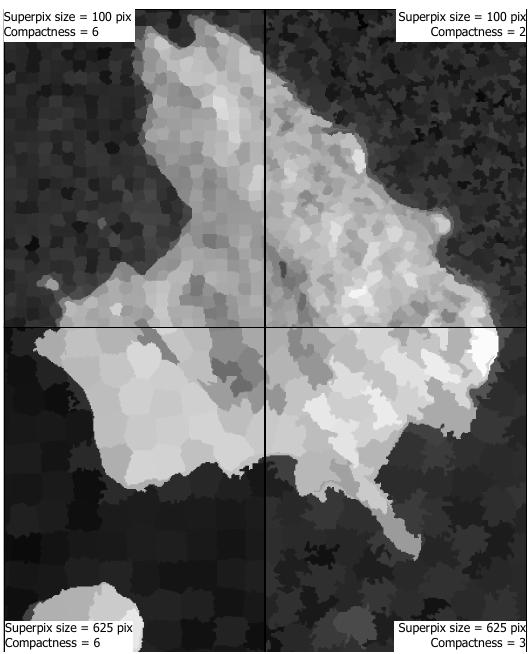
Figure 2. Median filtering based on the superpixels region. The original data is a stack of 5 Sentinel-1 VH band acquired over the Lizard island, Australia.